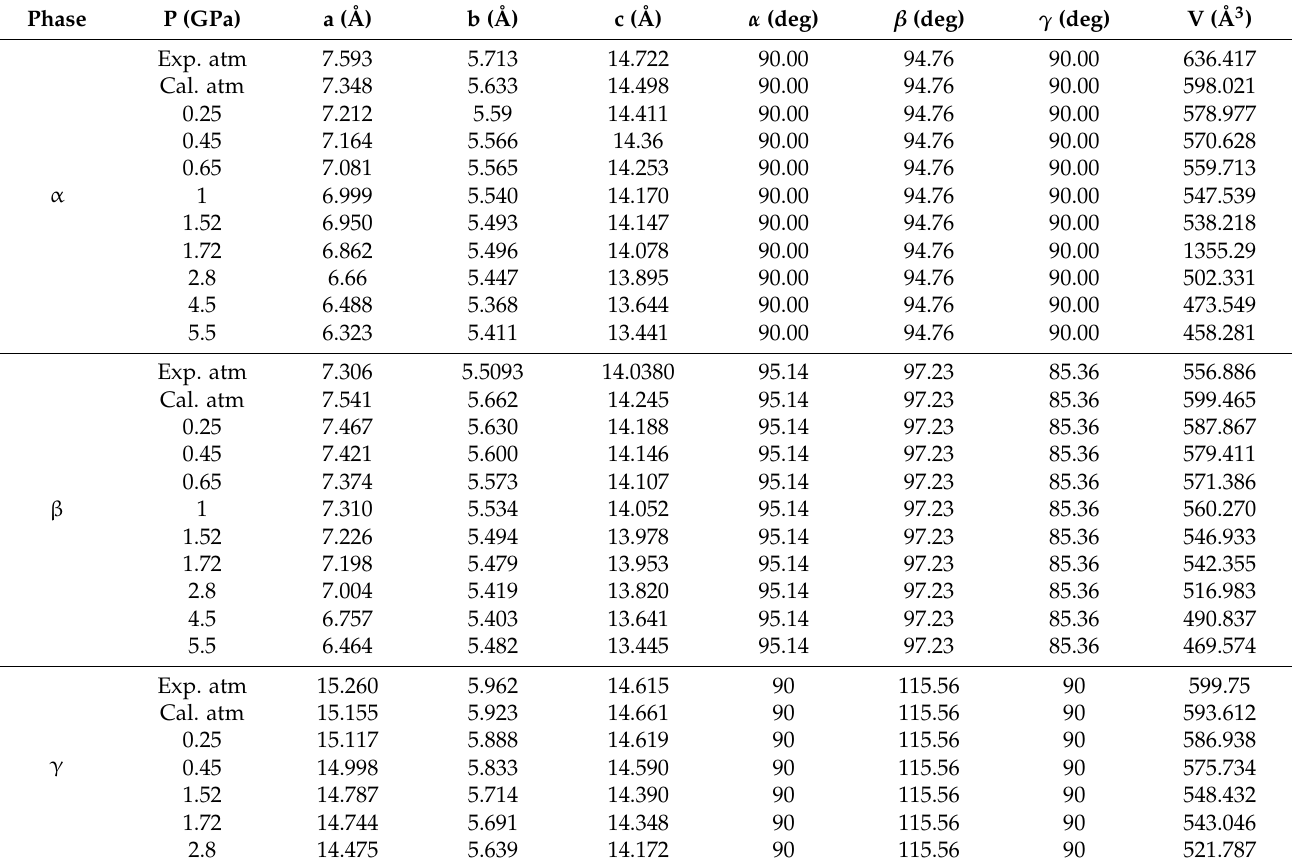
Table A1. Experimental and calculated crystal structure parameters of three phases of p-Tol 2 S 2